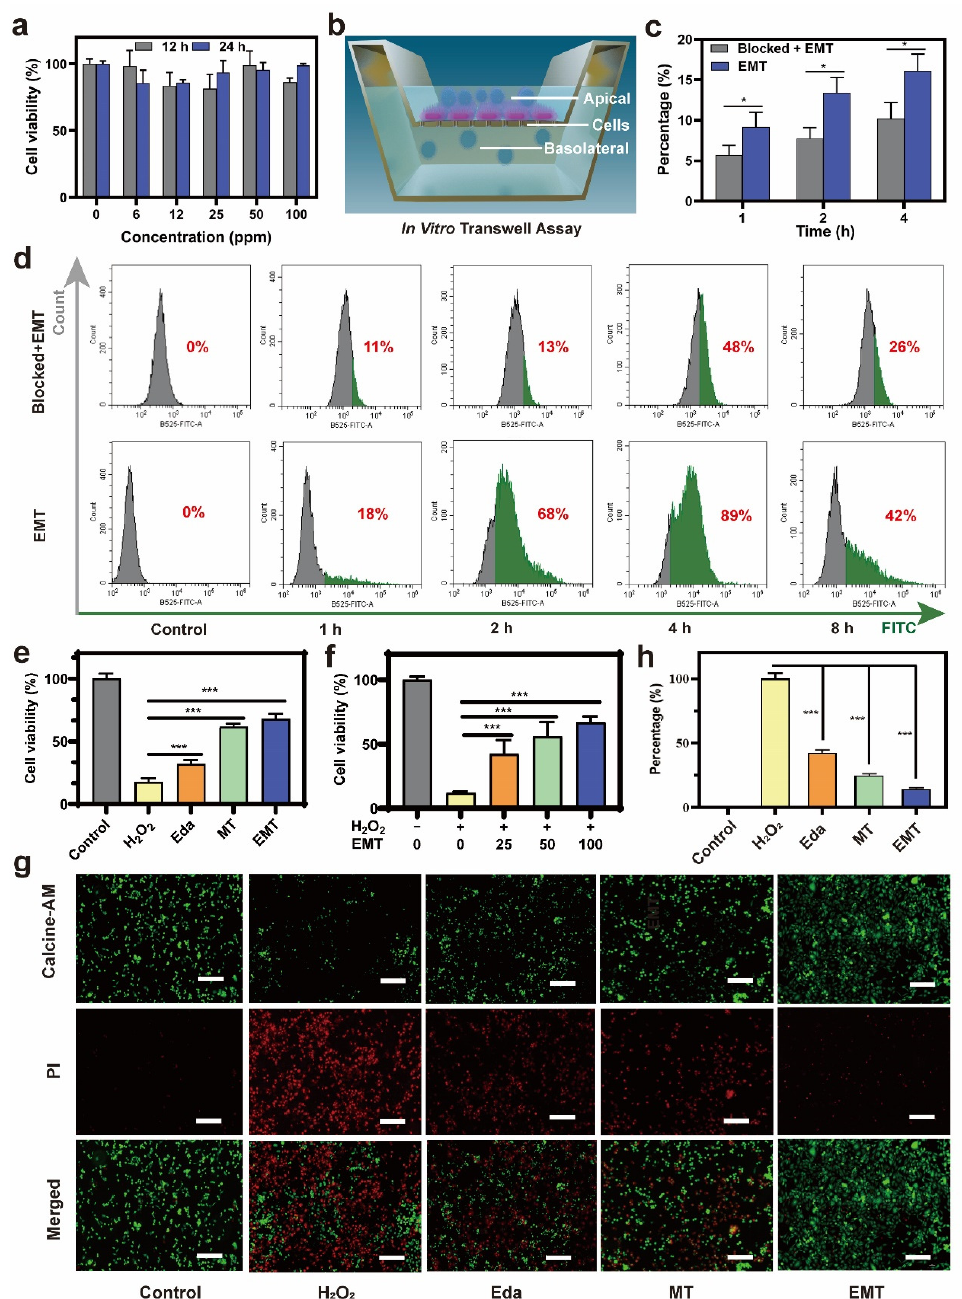
Figure 4. BBB penetration in vitro and therapeutic effects at the cellular level. ( a ) Cytotoxicity of the EMT nanozyme with different concentrations after 12 and 24 h incubation in HUVEC cells. ( b ) Schematic diagram of the transwell assay for the in vitro BBB model. ( c ) Transcytosis capacity of EMT nanozymes and the ratio across the BBB at 1 h, 2 h, and 4 h. T test was used to calculate p value; * p < 0.05. ( d ) Cellular uptake assay demonstrating Tf on the surface of HUVEC cellular membranes promoting the uptake of EMT, reaching its peak at 4 h. ( e ) HUVEC cell viabilities of different groups (control, H 2 O 2 , Eda, MT, and EMT) to evaluate the therapeutic effects at the cellular level; *** p < 0.001. ( f ) Cell viability of H 2 O 2 -stimulated HUVEC cells with different concentrations of the EMT nanozyme; *** p < 0.001. ( g ) Calcein-AM/PI results were used to test the living (green) and dead (red) cells after exposing HUVEC cells to H 2 O 2 for two hours and the protective ability of Eda, MT, and EMT. Scale bar = 50 µ m. ( h ) The fluorescence intensity percentage of DCFH-DA to evaluate ROS-relieving ability with different groups (control, H 2 O 2 , Eda, MT, and EMT); *** p <